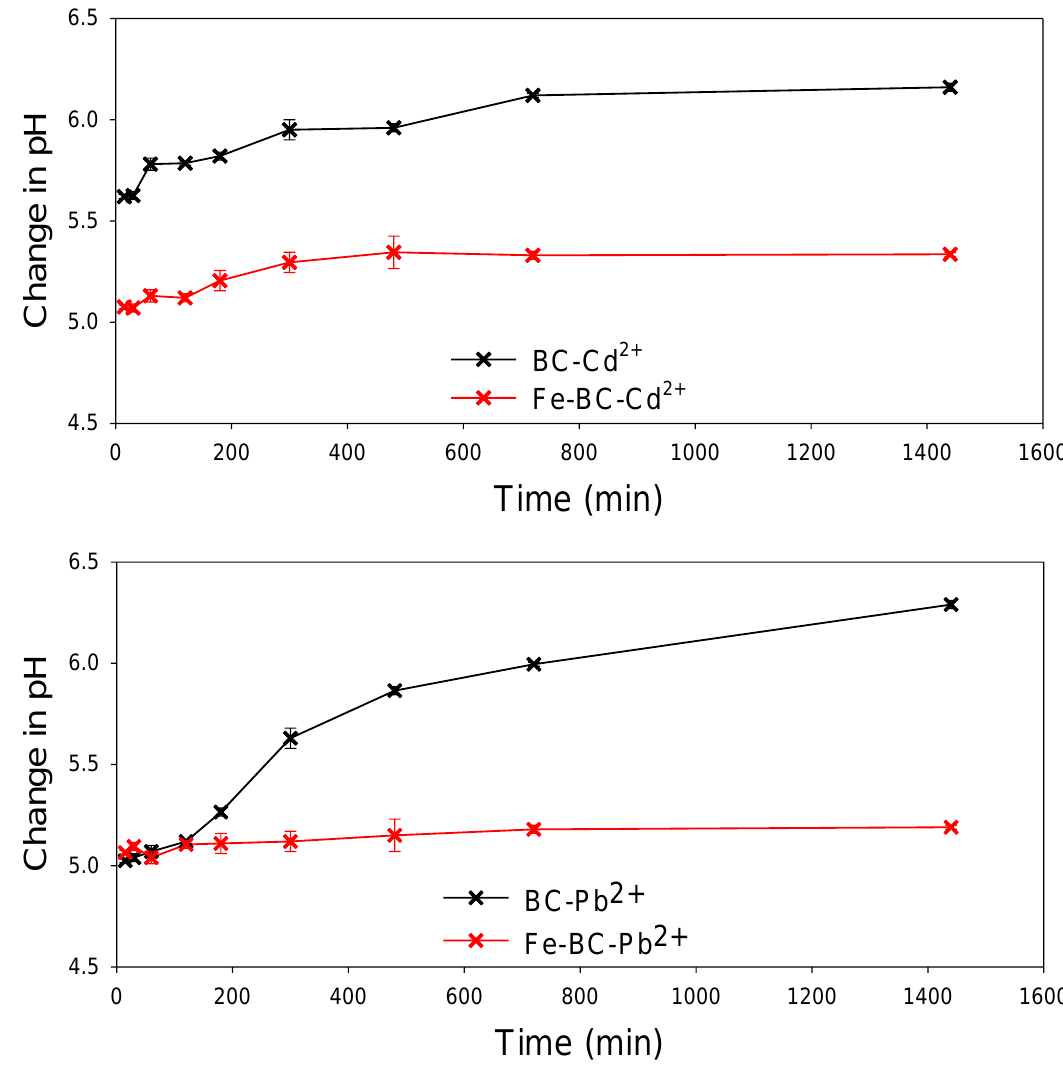
Figure 6. Changes in solution pH with time for the adsorption of cadmium (Cd 2+ ) and lead (Pb 2+ ) ions on date palm waste biochar (BC) and Fe-modified biochar (Fe-BC).